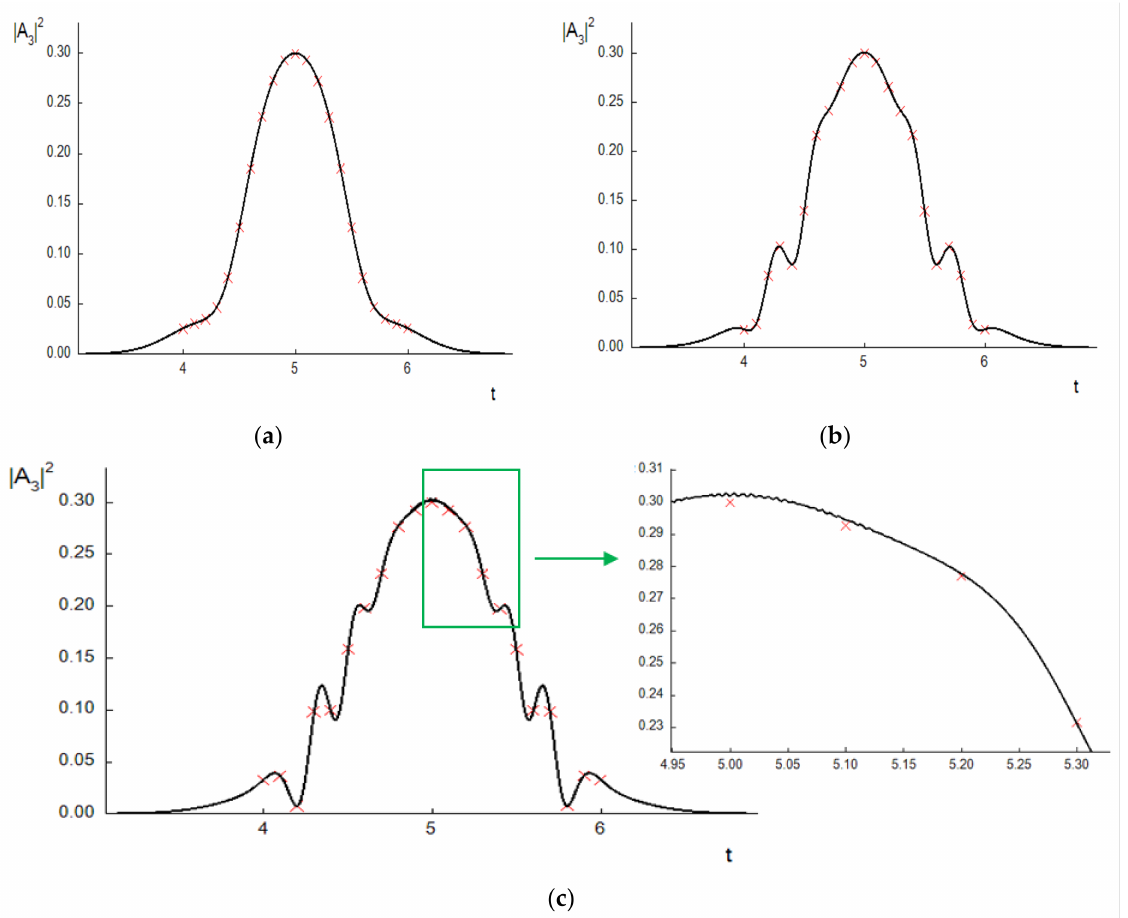
Figure A1. TH pulse shape in the sections z = 1 ( a ), 3 ( b ), 5 ( c ) computed using CFDS-I3 (solid line) and using analytical formula (red